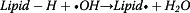
The reaction of MDA (malondialdehyde) and 2-thiobarbituric acid (TBA).